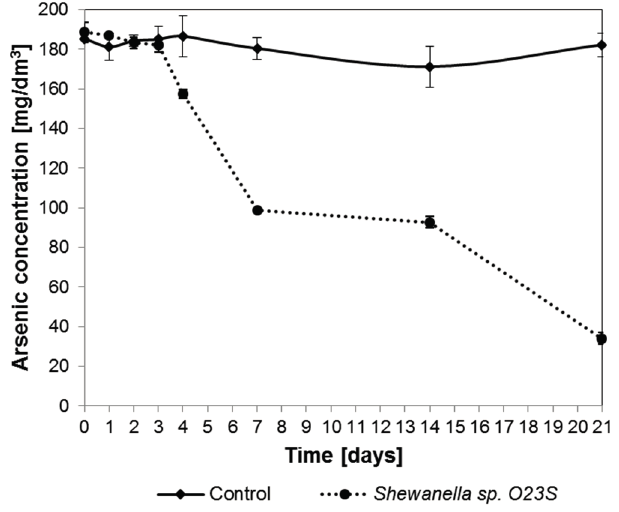
Figure 8. Removal of arsenic from synthetic water containing 5 mM sodium lactate, 2.5 mM (187.5 mg As/dm 3 ) sodium arsenate, and 5 mM (560 mg/dm 3 ) sodium